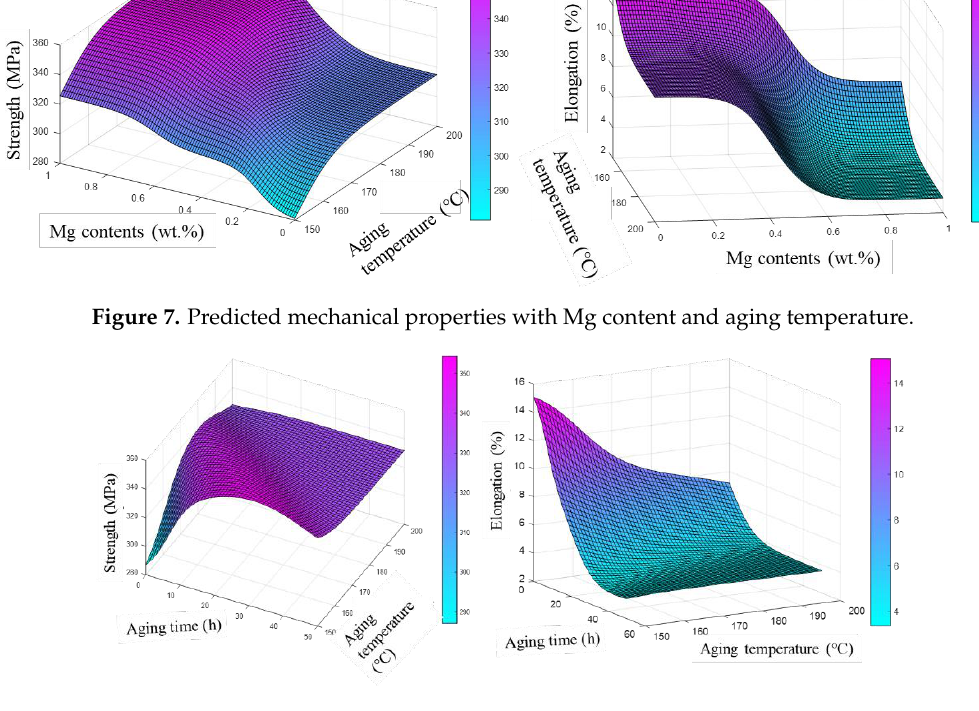
Figure 9. Isograms of UTS and elongation of Al–7Si alloy with different parameters: (a)Mg contents and Aging temperature; (b) Mg contents and Aging time and (c) Solution time and Aging time. 3.5. Quantitative Relationship between Mechanical Properties and Variables